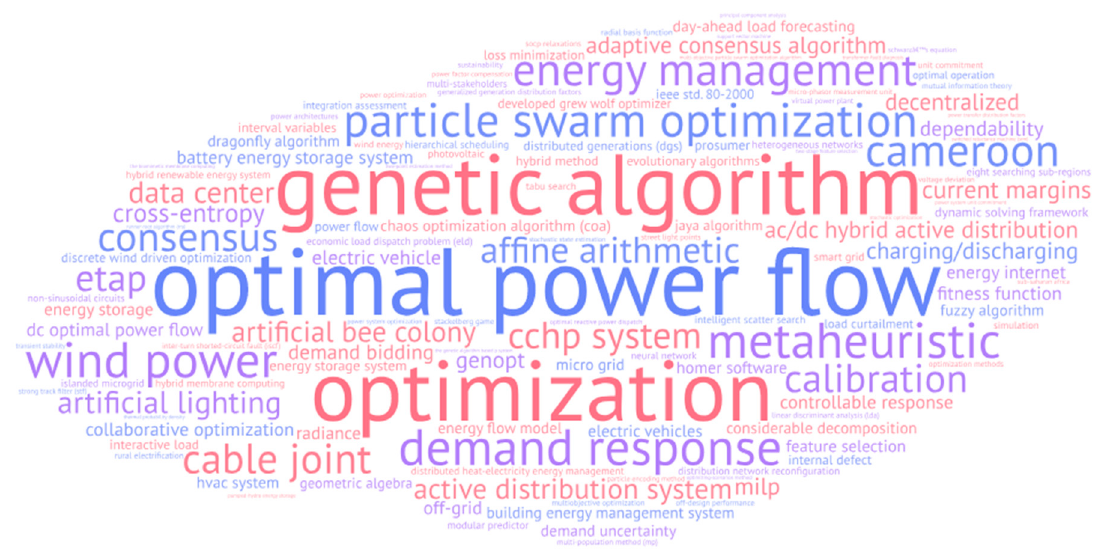
Figure 1. Cloud word of the author keywords related to the special issue.